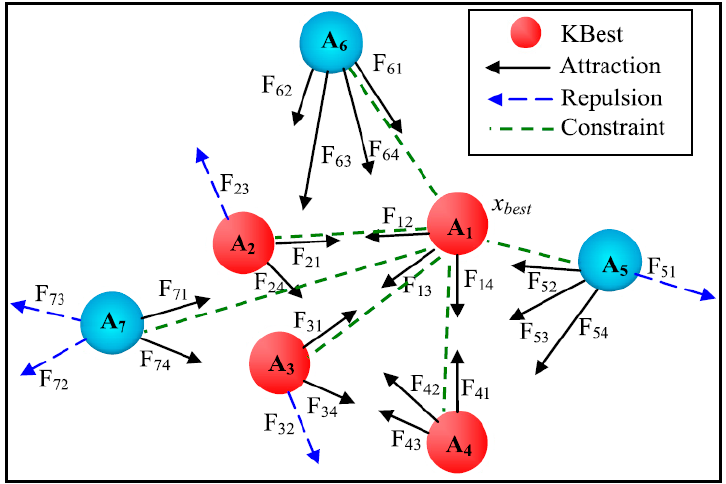
Figure 3. Forces in an atom arrangement through K best when K = 4